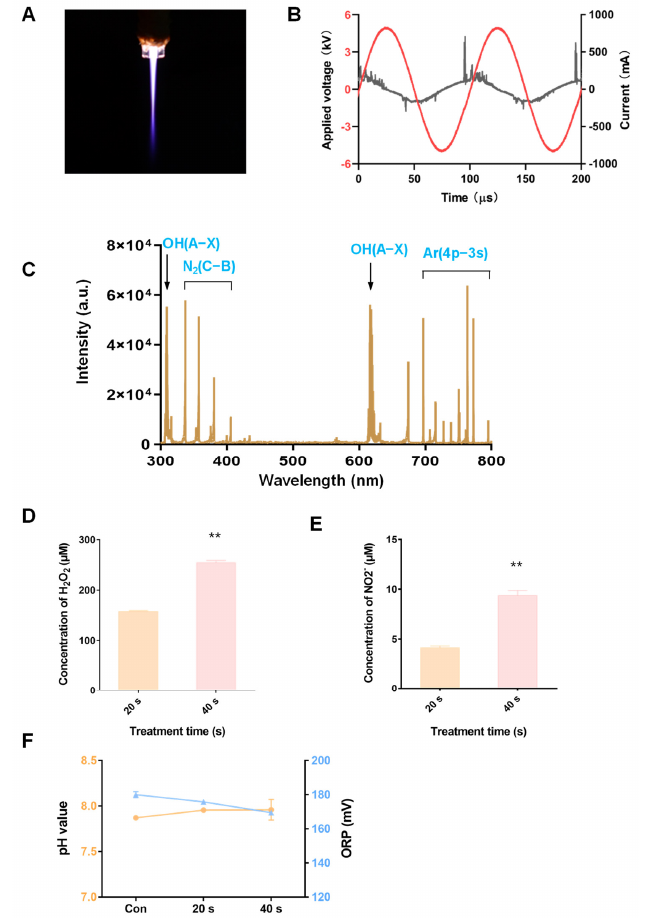
Figure 3. Physicochemical properties of Ar plasma. ( A ) The discharge image, ( B ) the waveforms of the voltage and current, and ( C ) the optical emission spectrum (OES) of Ar plasma. When Ar plasma treated the cell culture medium for 20 s and 40 s, the concentrations of ( D ) H 2 O 2 and ( E ) NO 2− , and ( F ) the pH value and ORP were measured. Data represent the mean ± SD; ** p < 0.01 (Student’s t test).